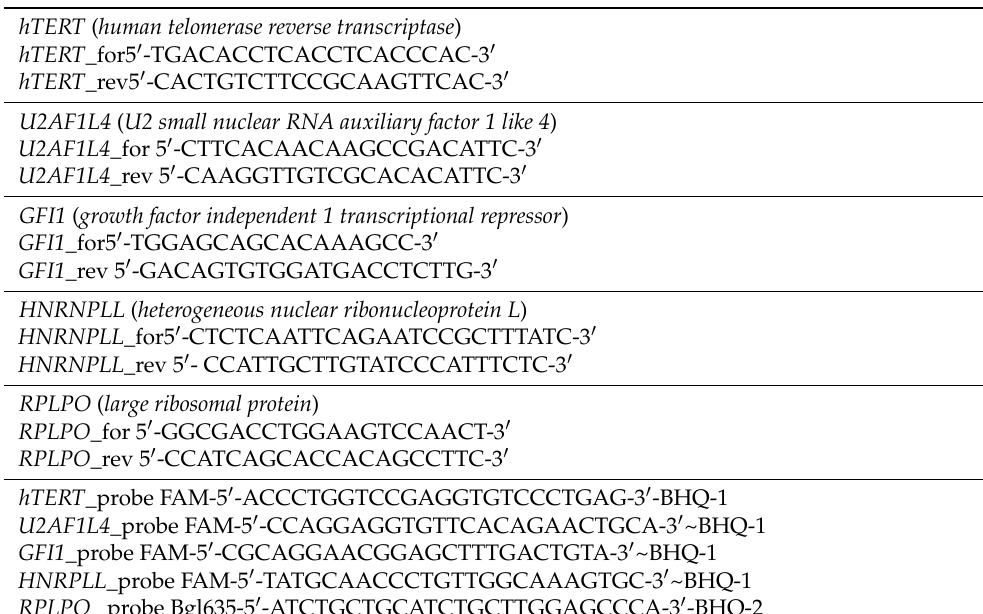
Table 1. Sequences of oligonucleotide primers used in the experiment. hTERT ( human telomerase reverse transcriptase ) hTERT _for5 (cid:48) -TGACACCTCACCTCACCCAC-3